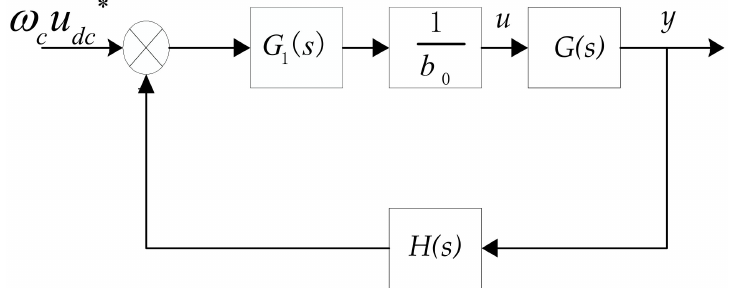
Figure 11. Based on the improved LADRC photovoltaic system voltage outer ring control